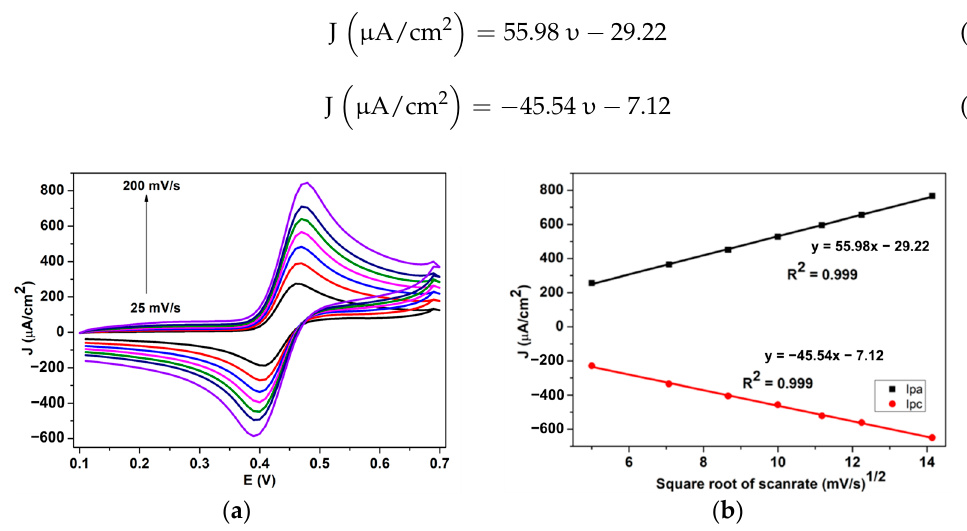
Figure 9. ( a ) CV results of the scan rate variation of 1 mM dopamine in 0.1 M HCl of AuNS-modified SPCE and ( b ) the linearity curve between the square root of the potential scan rate and the anodic- cathodic peak current.